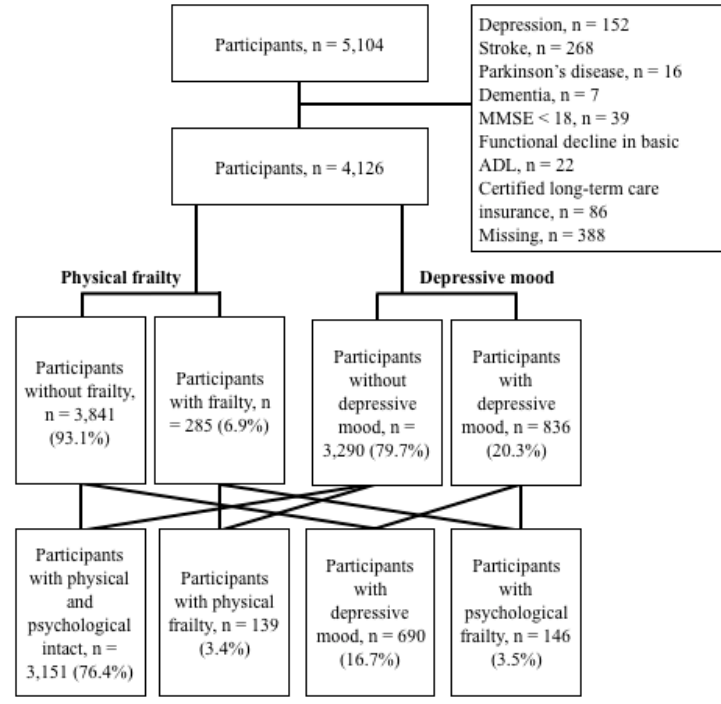
Figure 1. Participants’ flow and frailty